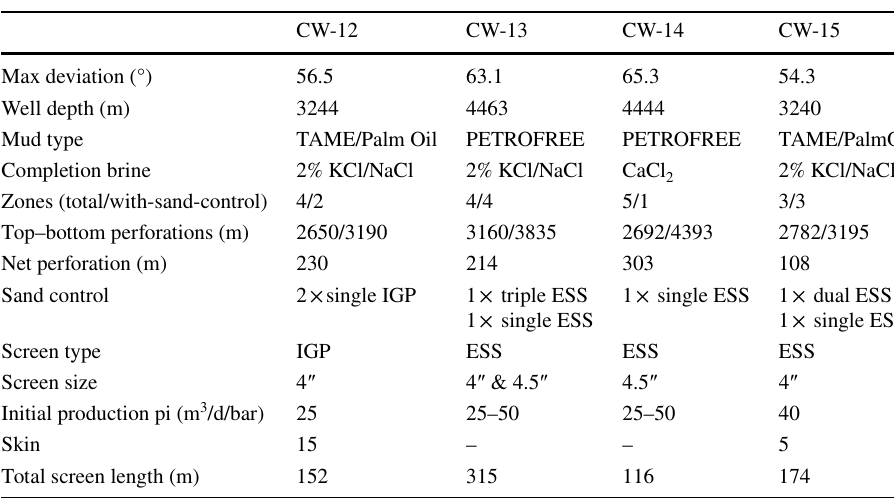
Table 5 Champion West wells data (Saeby et al.